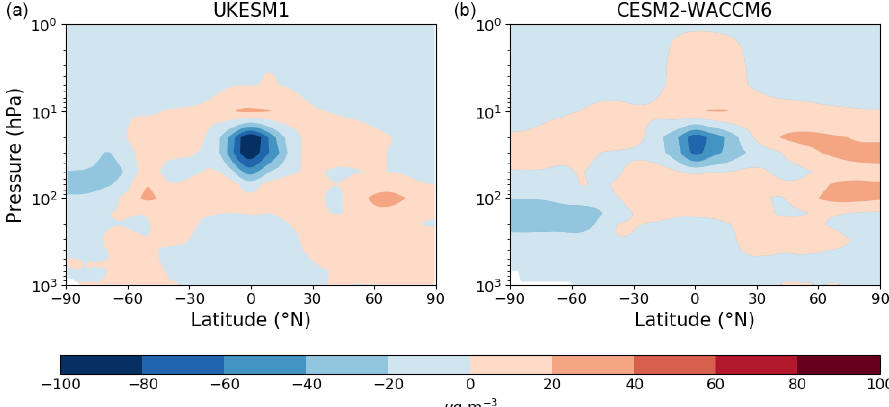
Figure 3. The difference in 2081–2100 annual-mean ozone concentrations (µgm − 3 ) diagnosed from { G6sulfur minus G6solar } for UKESM1 (a) and CESM2-WACCM6 (b)